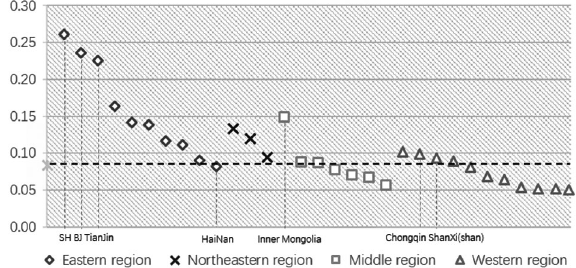
Figure 3. Spatial distribution of relative technology